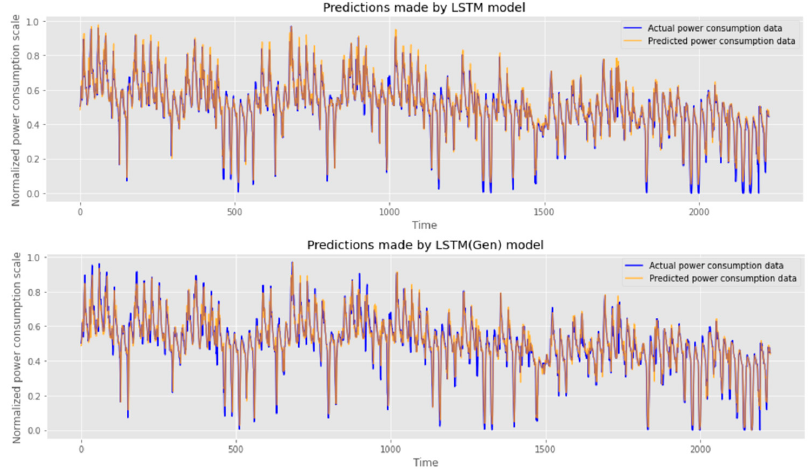
Figure 9. Comparison of performance between existing LSTM model ( top ) and optimized LSTM model ( bottom ).